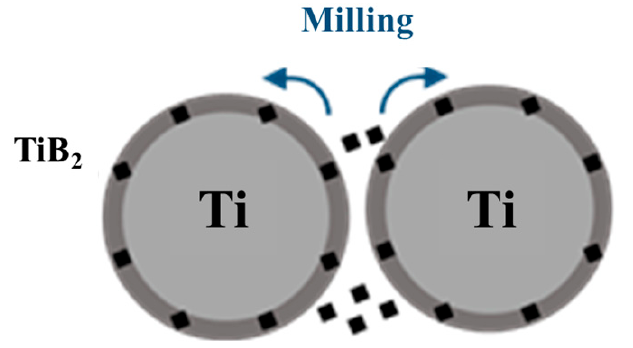
Figure 3. Preparation of core-shell Ti-B 4 C composite by ball milling.